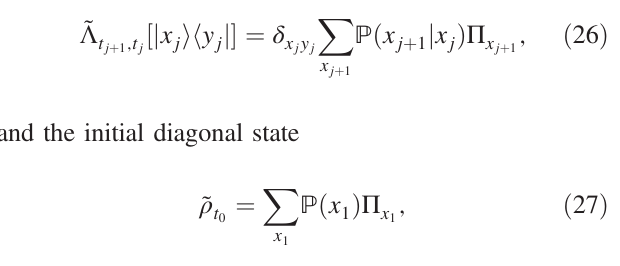
FIG. 4. NCGD dynamics. If the process is NCGD, then for a classical observer, “ doing nothing ” (i.e., performing the map I ) cannot be distinguished from a measurement in the classical basis and averaging over the outcomes (i.e., performing the map Δ ) at any point in